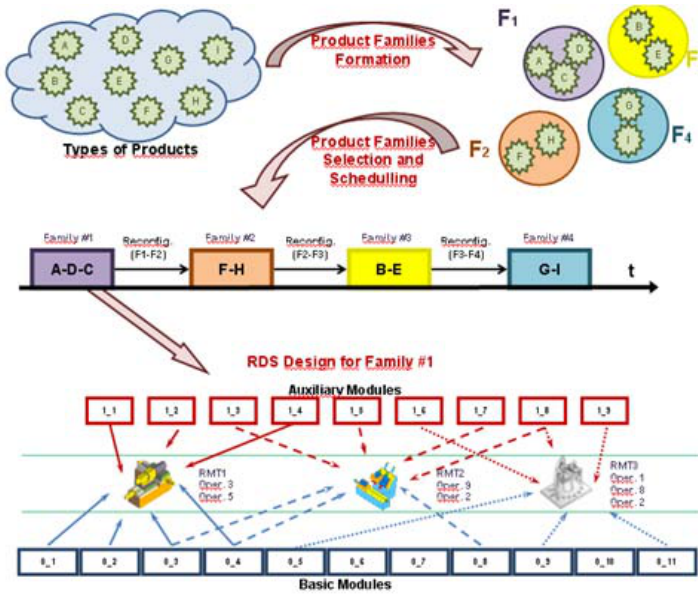
Figure 1. Schematic representation of the proposed